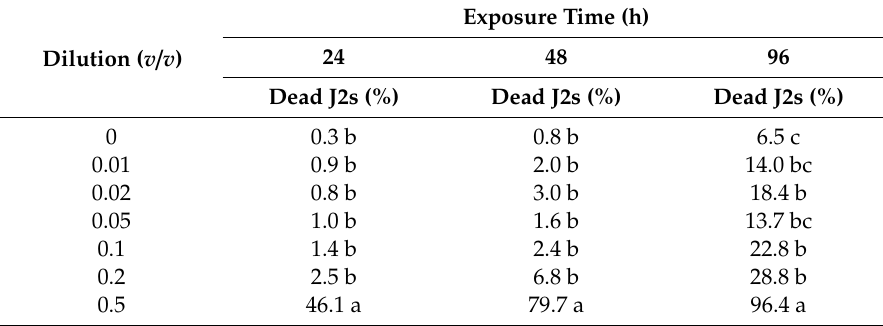
Table 5. E ff ect of hydrosol on the motility of M. javanica J2s after immersion in test solutions at